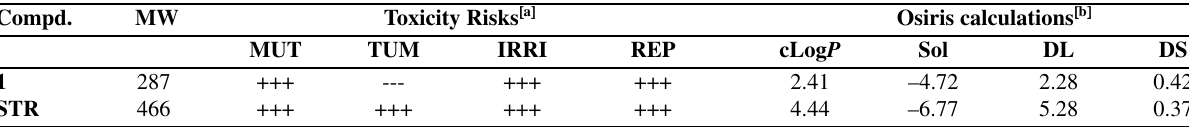
Table 1 . Osiris calculations of toxicity risks of staurosporine ( STR ) and its derivative ( 1 ).